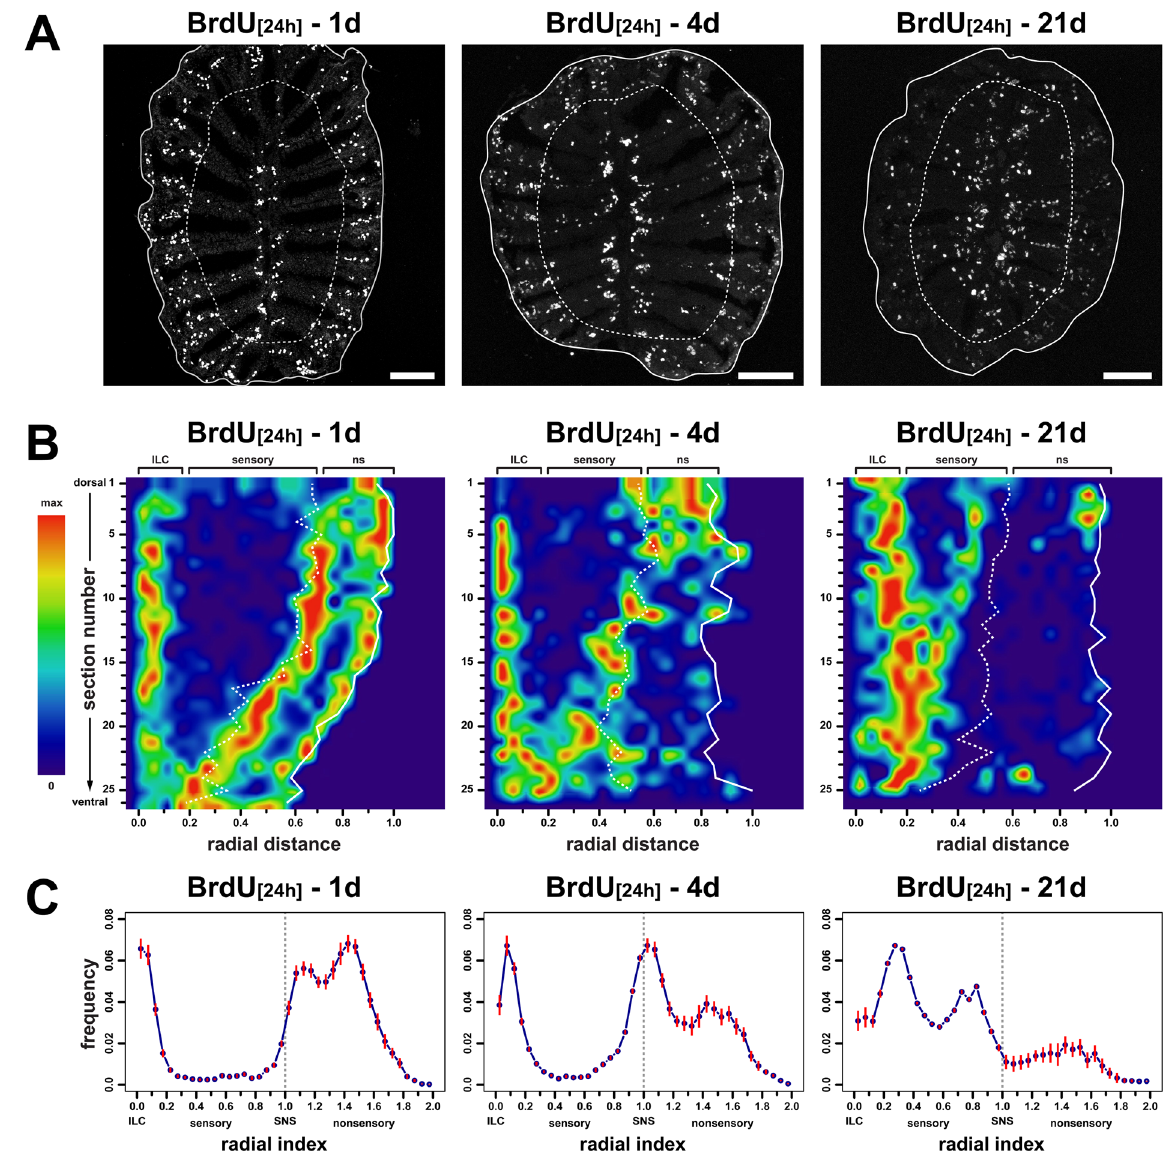
Figure 2. Adult-born cells invade the sensory epithelium over time. ( A ) Immunohistochemistry against BrdU following 24 h BrdU incubation 1d (left), 4d (centre), and 21d post labelling on sections through the adult OE. The dotted line indicates the position of the sensory/nonsensory border and the solid line demarcates the outline of the section. BrdU-positive cells are located at the interlamellar curves (centre of the sections) and peripherally to the sensory/nonsensory border initially but progressively invade the sensory OE. Scale bars: 100 µ m. ( B ) Reconstructions of surface views onto a standardized olfactory lamella as shown in Fig. 1A 1d (left), 4d (centre), and 21d (right) following BrdU incubation for 24 h. The radial positions of BrdU-positive cells (left to right) were normalized to the maximum radius of the OE (radial distance) and plotted individually for each of 25 to 26 consecutive sections from the dorsal (top) to the ventral (bottom) margin of the OE. The circumference of the OE is indicated by a solid white line, the dotted line demarcates the average position of the SNS from all lamellae on the respective section. The frequency of BrdU-positive cells within each bin was normalized to the total number of BrdU-positive cells per section (max). The image has been smoothened with a bicubic scaling function. For a representation of unprocessed data see Supplementary Figure 2. ( C ) Frequency distributions of BrdU-positive cells 1d (left), 4d (centre), and 21d (right) following 24 h BrdU incubation. The position of labelled cells was normalized to the distance of the sensory/nonsensory border (SNS) from the tip of the interlamellar curves (ILCs). The dotted line demarcates the position of the SNS. Data points represent means ± SEM for 14.365 (1d), 10.967, (4d), and 7.463 (21d) cells from 30 sections of 3 OE for each time point. BrdU-positive cells originating from the ILC and SNS progressively invade the sensory OE over time, while cells in the periphery of the OE remain stationary. An additional population of non-migratory cells becomes visible at the ILC for the 21d time